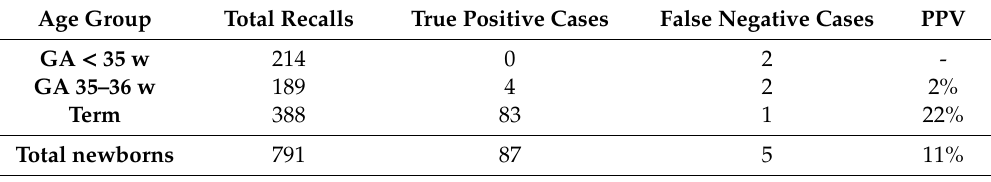
Table 1. All recalls, true positive cases, false negative cases and PPV values for the CAH screening in Sweden of more than one million children between 2011 and 2019.